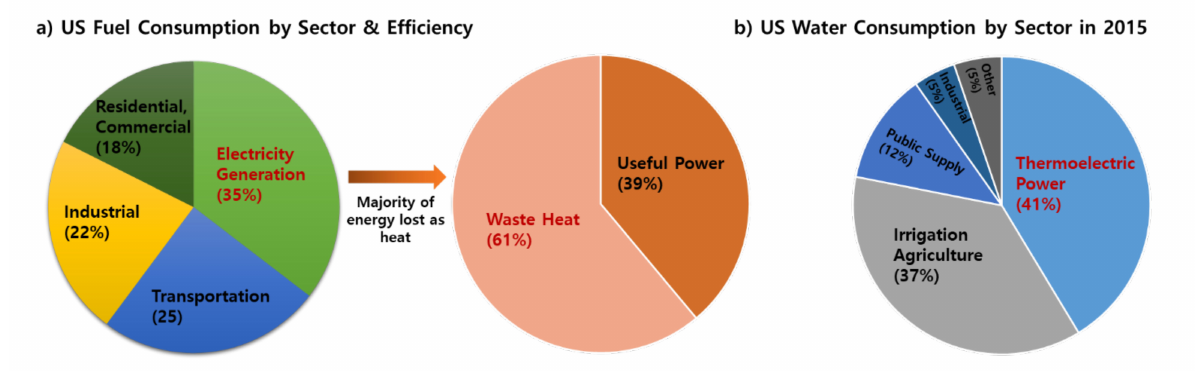
Figure 1. ( a ) USA fuel consumption by sector and corresponding energy efficiency, ( b ) USA water consumption by sector in 2015 (data obtained from